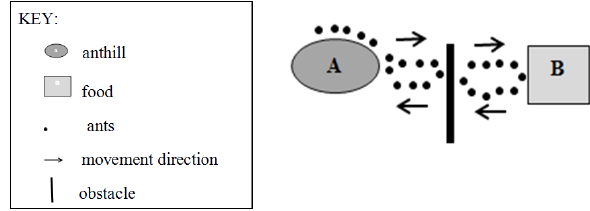
Figure 2: The ants’ behavioral pattern in case of an obstacle